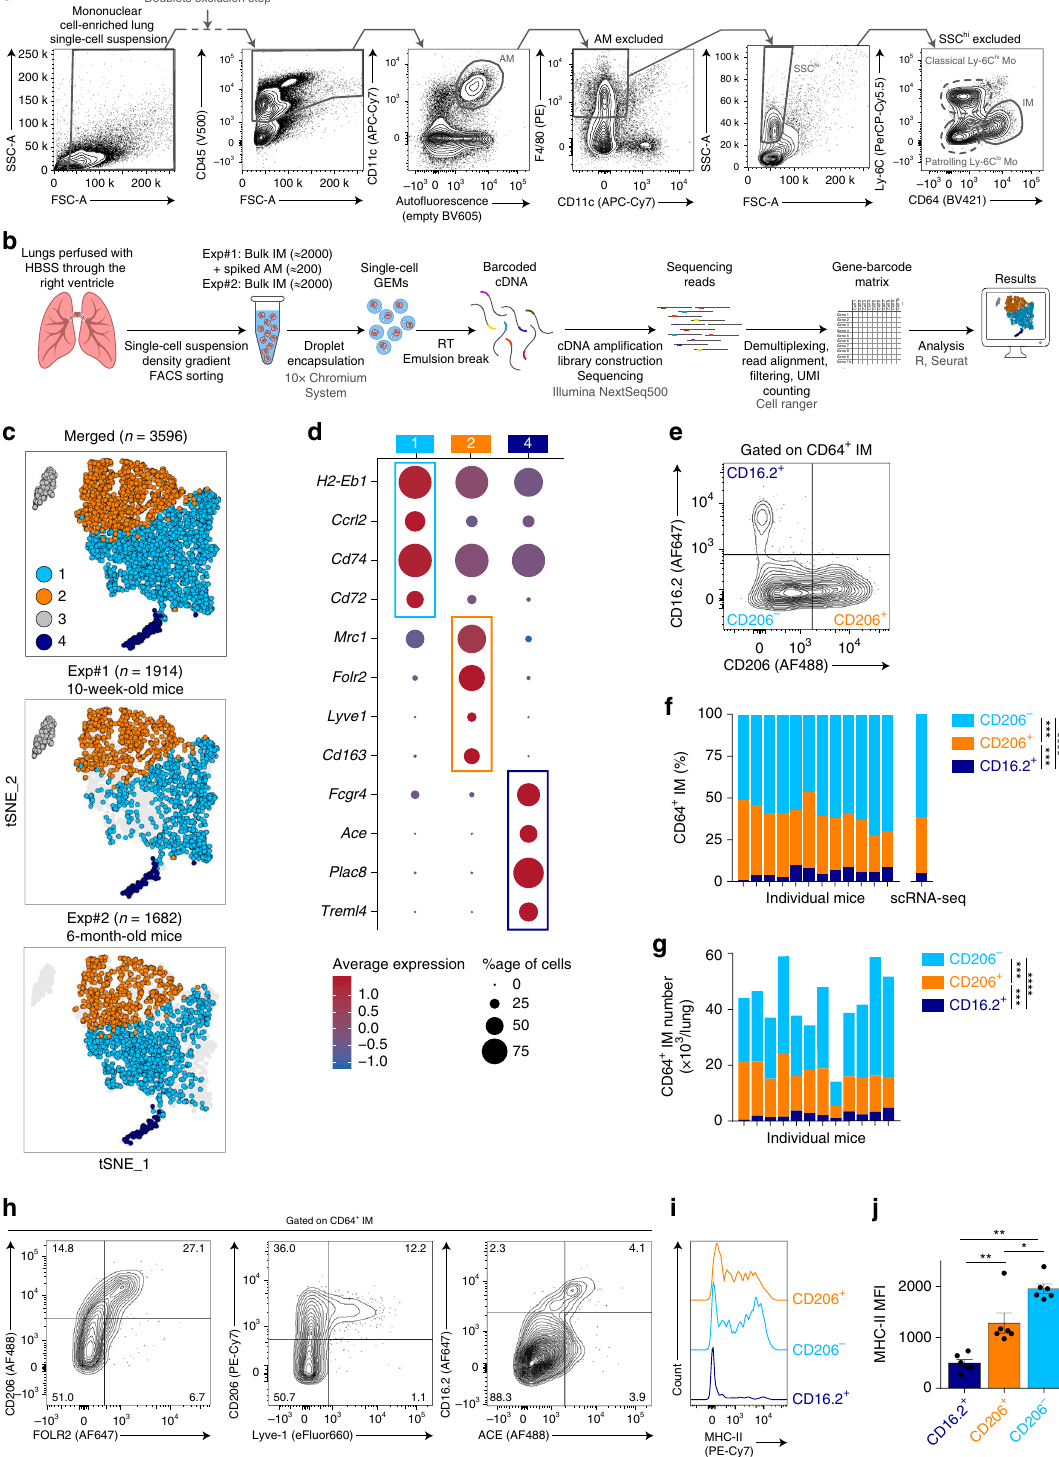
We also sought to test the ability of each subpopulation to engulf large particles (i.e., E. coli bioparticles conjugated with a pH-sensitive dye), i.e. a functional hallmark of macrophages (Fig. 2g). Like AM, CD64 + CD16.2 + monocytes, CD206 + and CD206 − IM were able to phagocyte airborne and blood-borne particles, with signi fi cantly higher percentages of cells when particles were injected i.t. as compared to i.v. (Fig. 2h). After